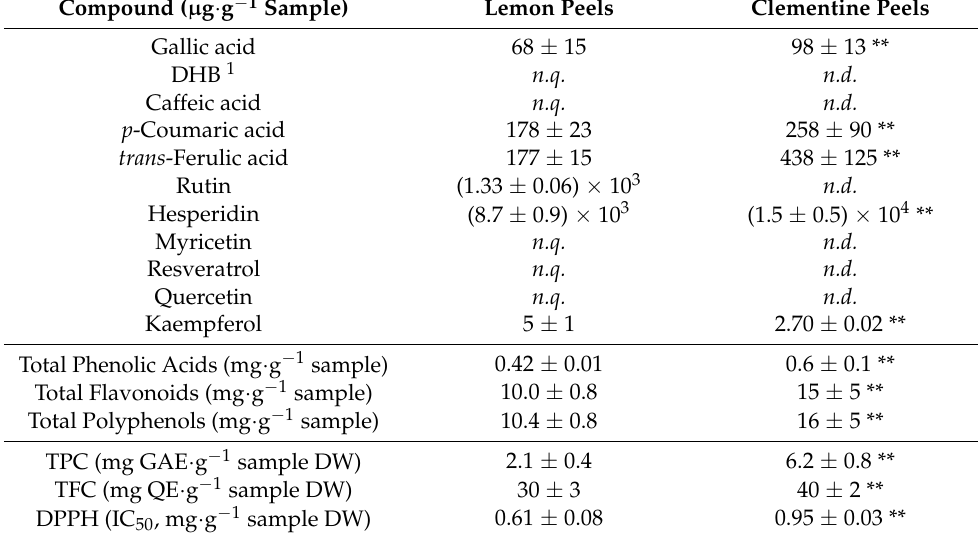
Table 3. Phenolic compounds and estimated values of total content and antioxidant activity of raw extracts obtained from lemon and clementine peels. Data are expressed as mean ± standard deviation ( n ≥